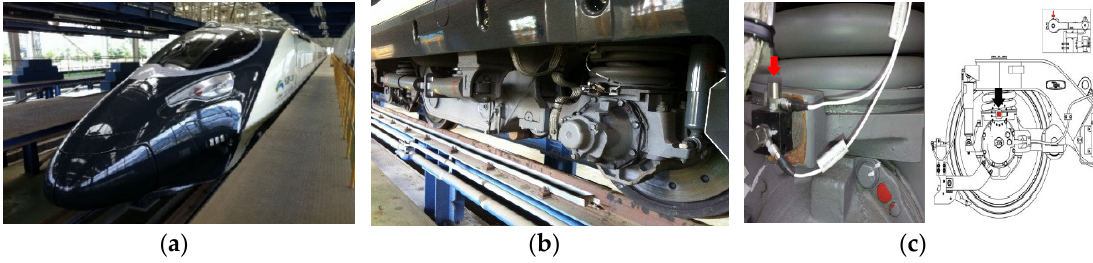
Figure 4. The sensor installation position on the axle of a high-speed train: ( a ) the high-speed train, ( b ) the bogie of the high-speed train, ( c ) the sensor at the axle